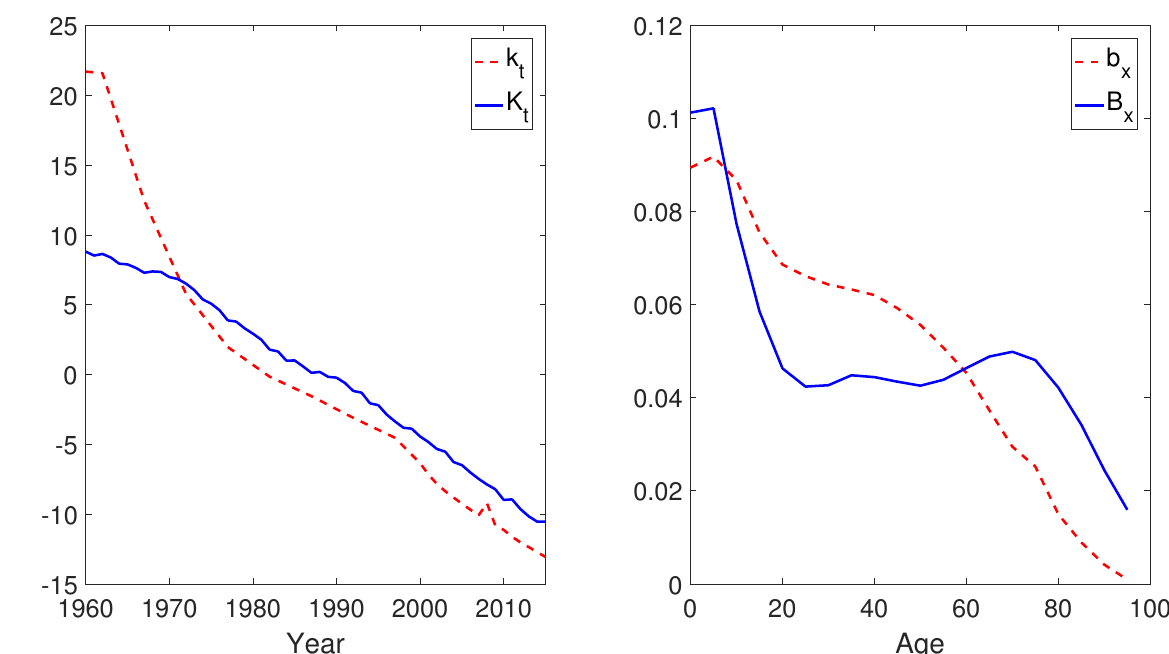
Figure 4. The historical period effects ( left panel ) and the age effects ( right panel ) of China and the benchmark populations.